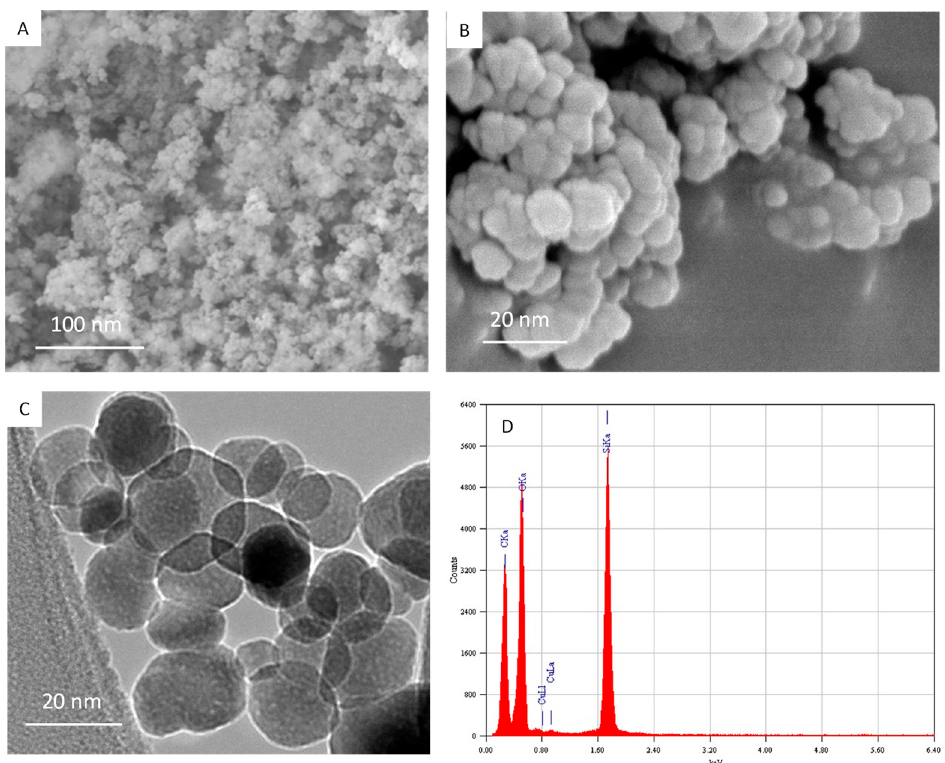
Figure1. CharacterizationofnSiO 2 . ( A , B )SEMimagesofnSiO 2 . ( C )TEMimageofnSiO 2 . ( D )Elemental Figure 1. Characterization of nSiO 2 . ( A , B ) SEM images of nSiO 2 . ( C ) TEM image of nSiO 2 . composition of nSiO 2 analyzed by energy dispersive X-ray spectroscopy (EDS). ( D ) Elemental composition of nSiO 2 analyzed by energy dispersive X-ray spectroscopy (EDS).